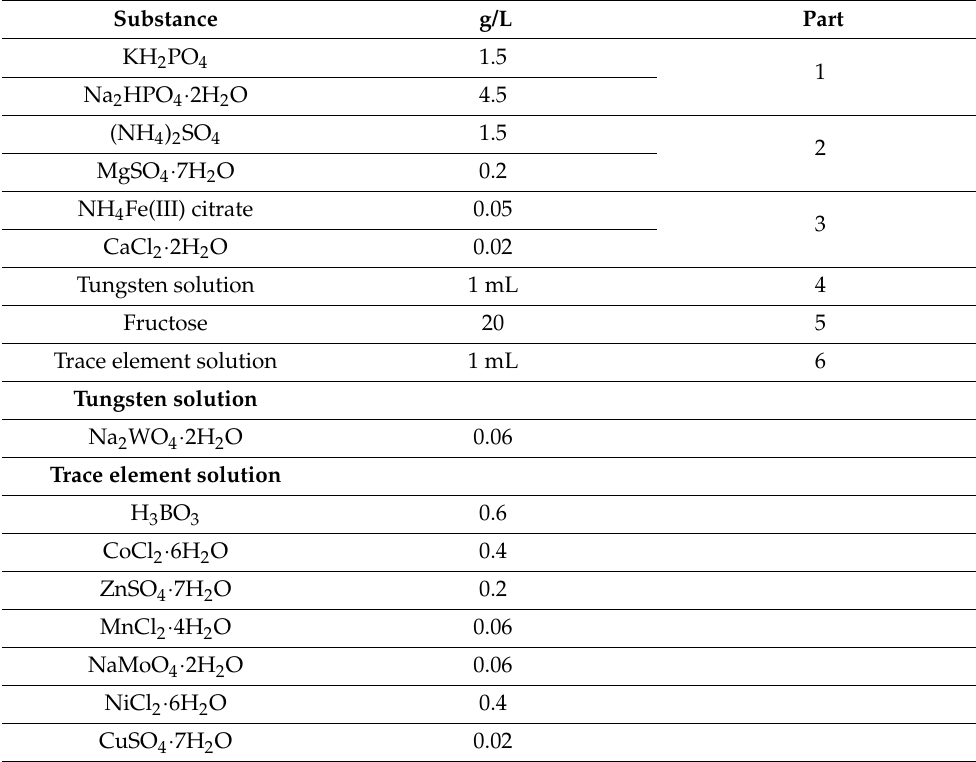
Table 1. Mineral media (MM) component list.